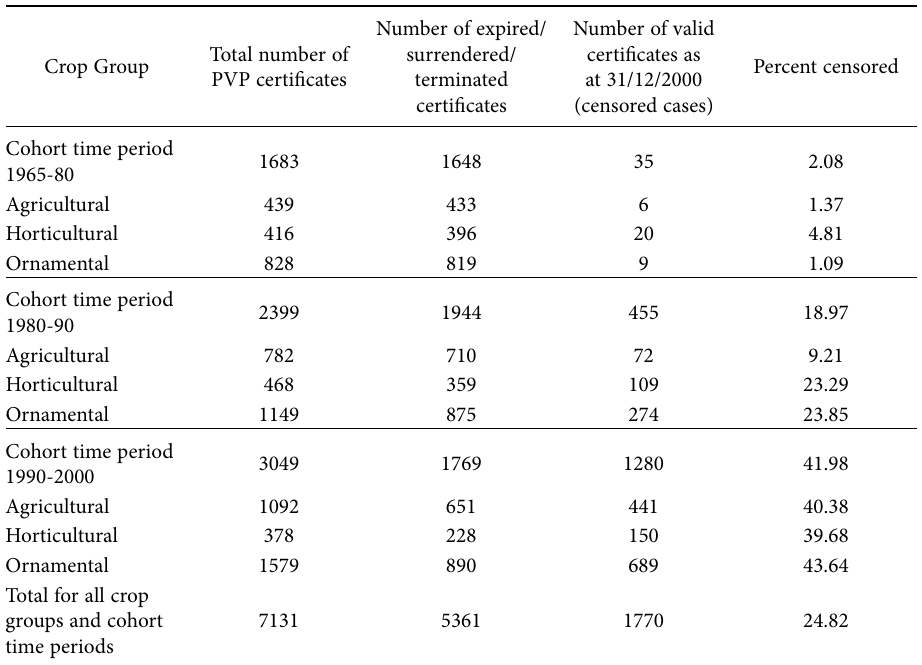
Table 3. Data for survival analysis by crop group and time periods